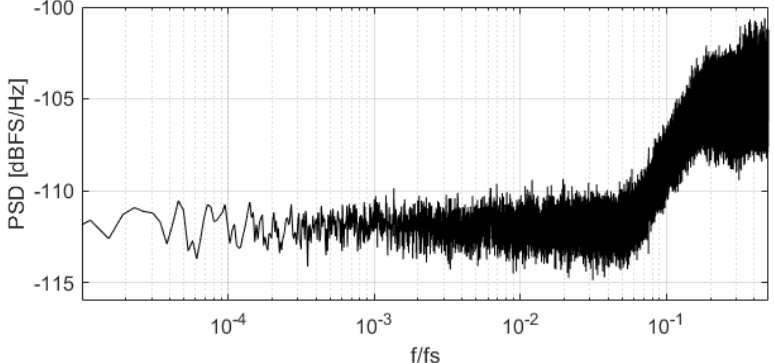
Figure 8. ( a ) In − band noise power; output signal is divided in segments of 4.8 ms. ( b ) | DAC (cid:48)(cid:48) in dB; each star symbol represents the value of this equation in a certain NP region.